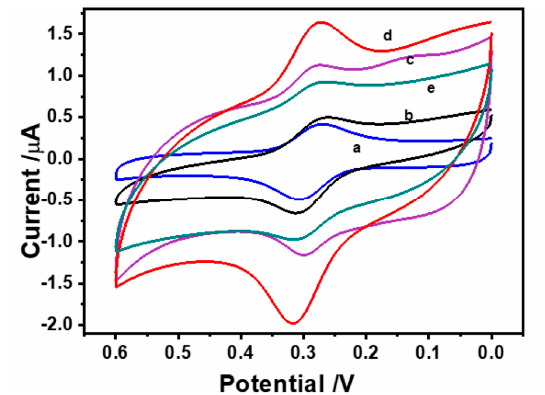
Figure 3. Cyclic voltammetries (CVs) of 0.5 μ M of LU on ( a ) GCE, ( b ) GO/GCE, ( c ) ErGO/GCE, ( d ) UiO-66/ErGO/GCE, ( e ) UiO-66/GCE in PBS (pH = 6.0) at scan rate of 0.01 V s − 1 .